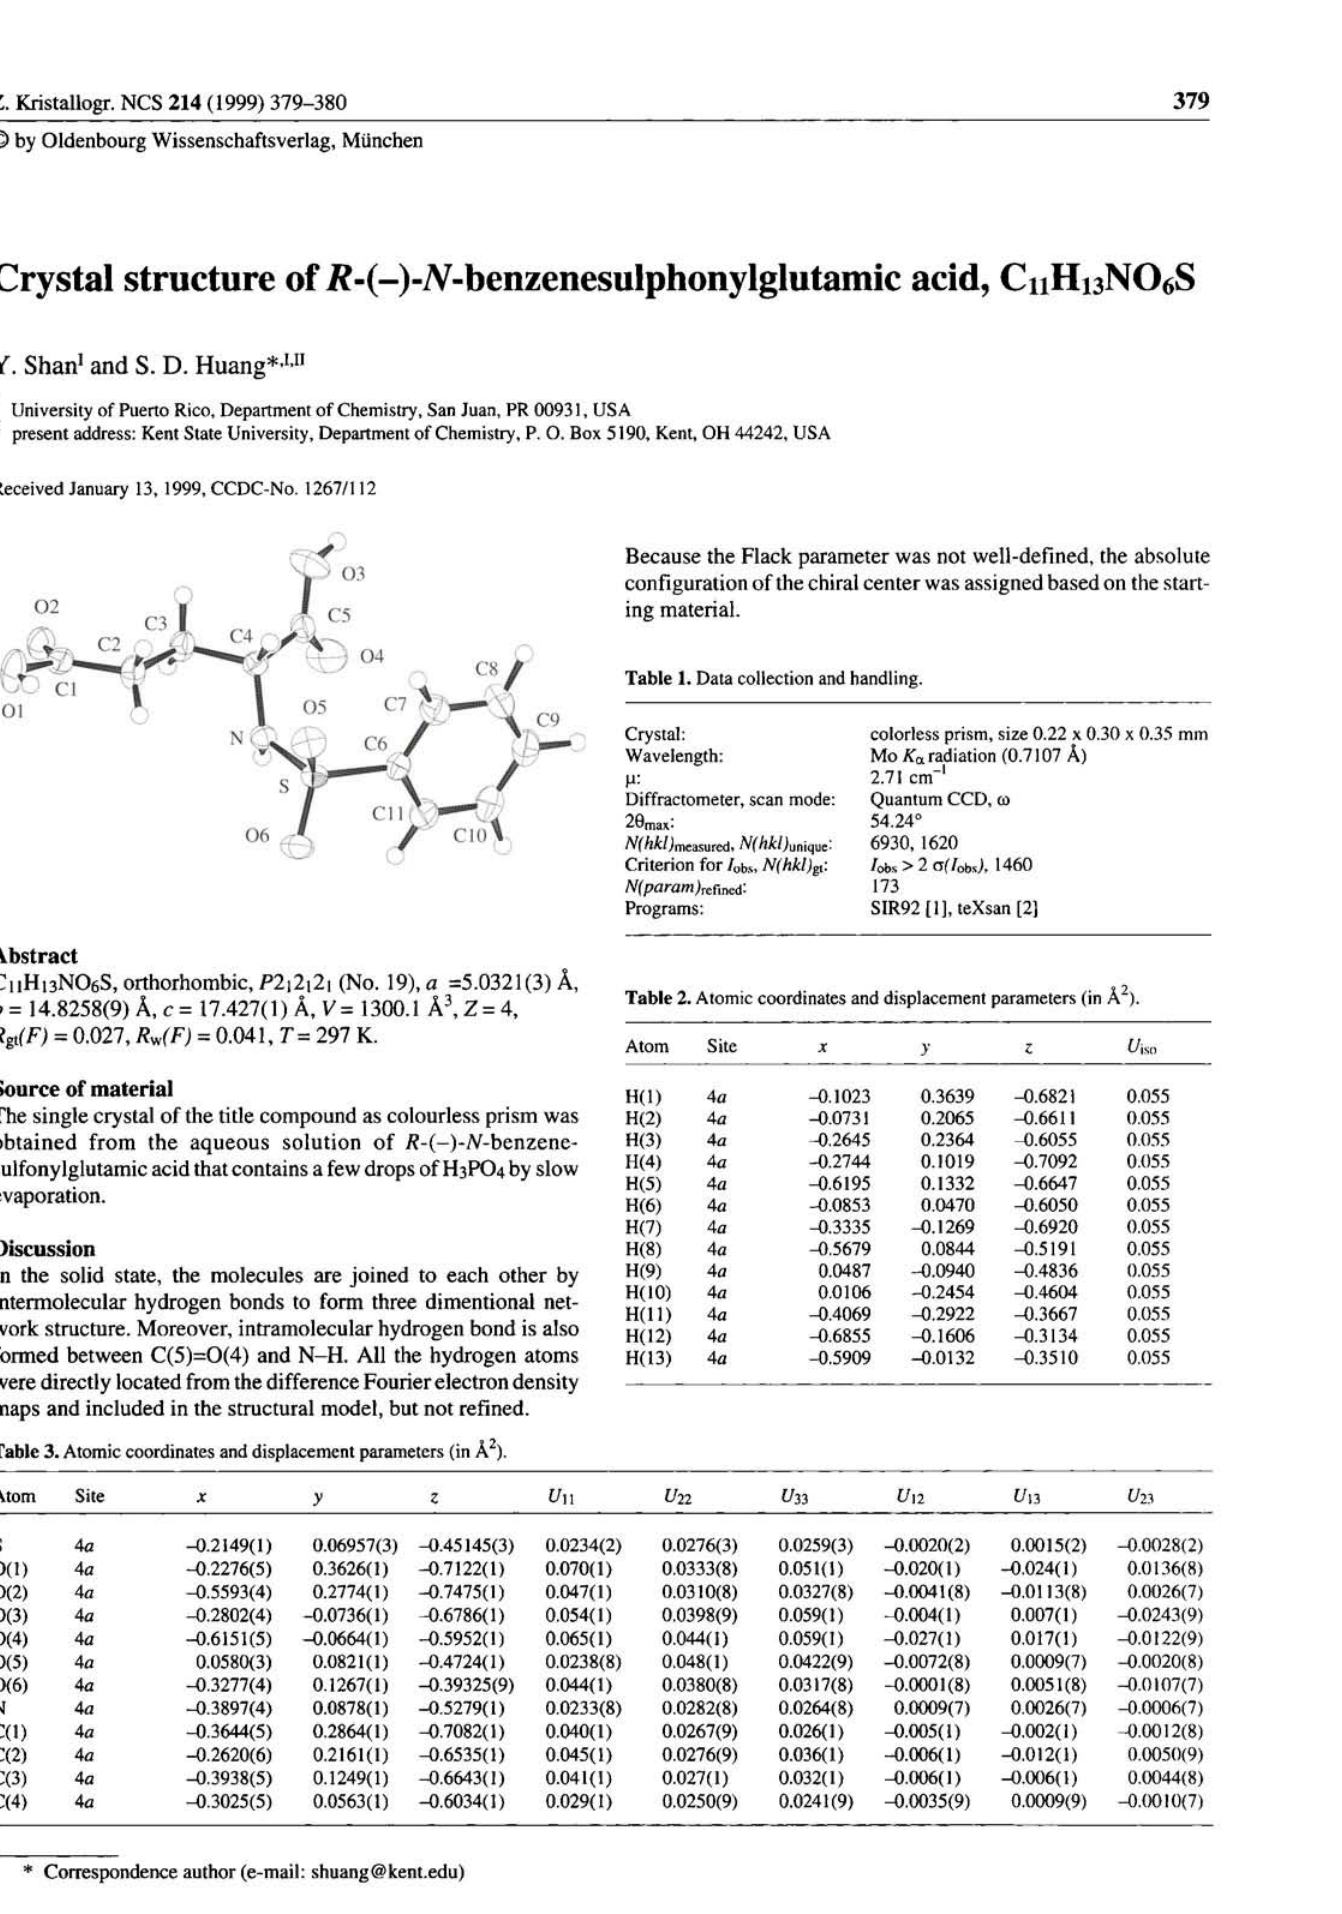
Table 3. Atomic coordinates and displacement parameters (in À 2 ).